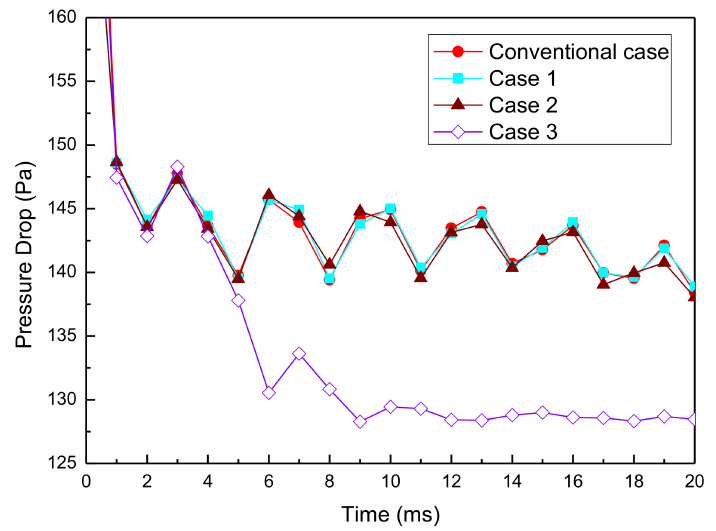
Figure 8. Pressure drop for the flow in the flow channel with various water droplet locations for the cases given in Table